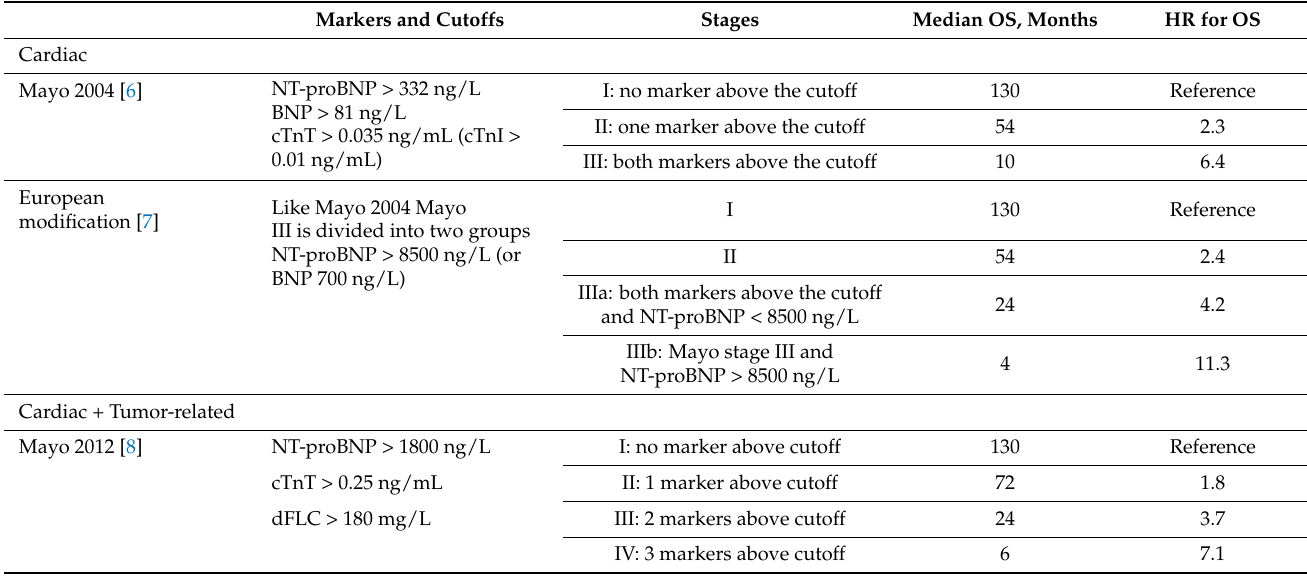
Table 1. Mayo staging systems and renal staging systems. NT-proBNP, amino-terminal portion of pro-brain natriuretic peptide type B; BNP, natriuretic peptide type B; cTnT, cardiac troponin T; cTnI, cardiac troponin I; hs-cTnT, high-sensitivity cardiac troponin; dFLC, difference between involved and uninvolved free light chain concentration; eGFR, estimated glomerular filtration